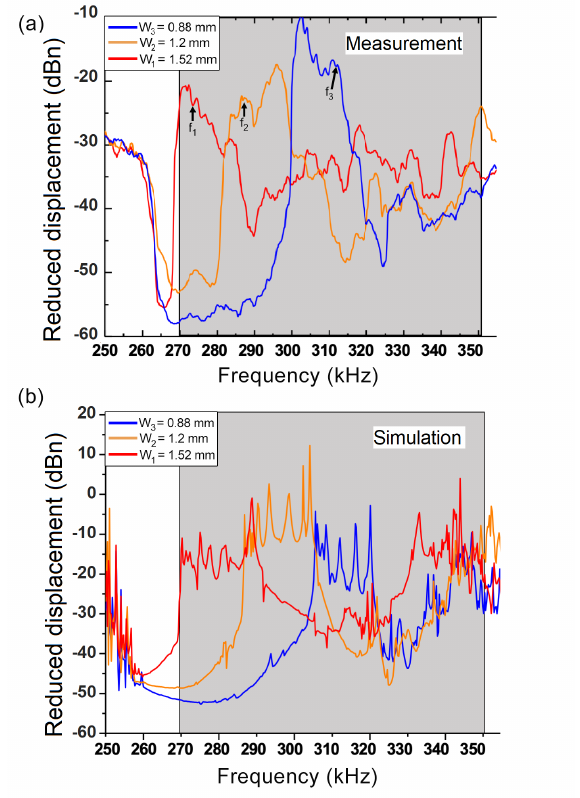
Figure 5. ( a ) Experimental and ( b ) simulated transmission spectra for three waveguide channels W 1 , W 2 , W 3 . The grey area marks the region for band